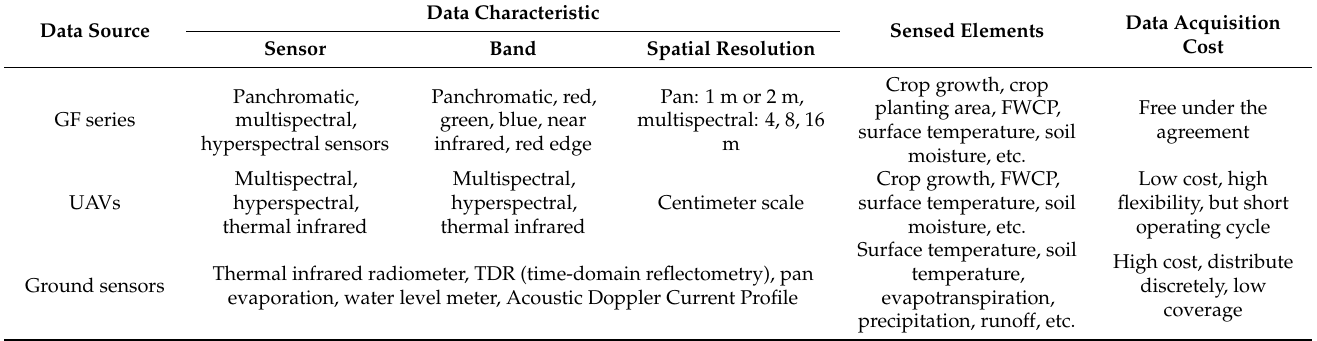
Table 2. Favorable multi-source data and the sensed monitoring elements of the collaborative sensing system.